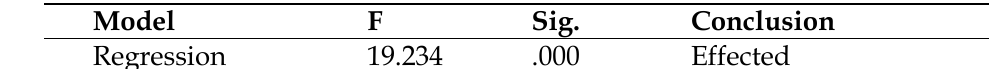
Table 4. Test Results of Simultaneous